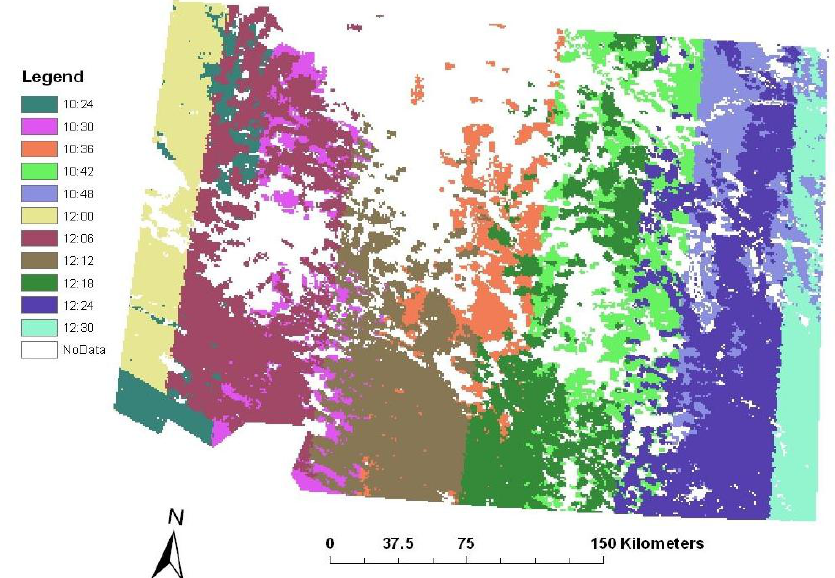
Figure 2. Solar View Time for MODIS Terra LST (MOD11A1) observations from 18 April 2008, covering the southwest corner of the Yukon